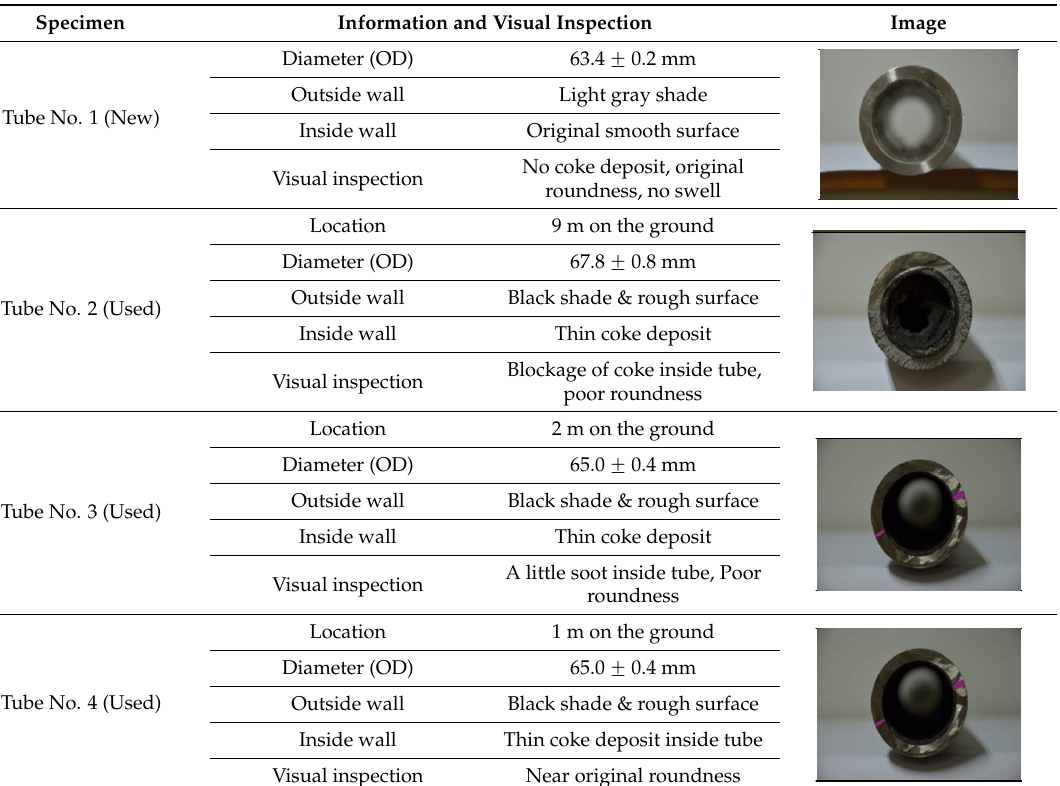
Table 1. Information of 35Cr-45Ni-Nb tube specimen and visuals inspection.